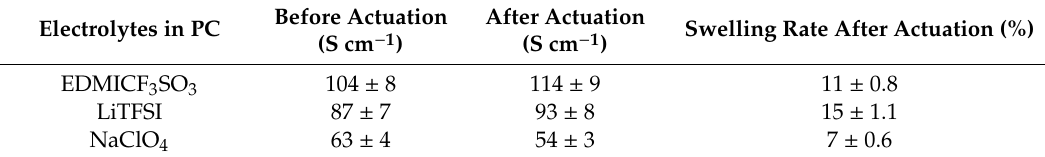
Table 1. PP–IPN trilayer electronic conductivities before and after actuation in different electrolytes. Before Actuation Electrolytes in PC (S cm − 1 ) Electrolytes in